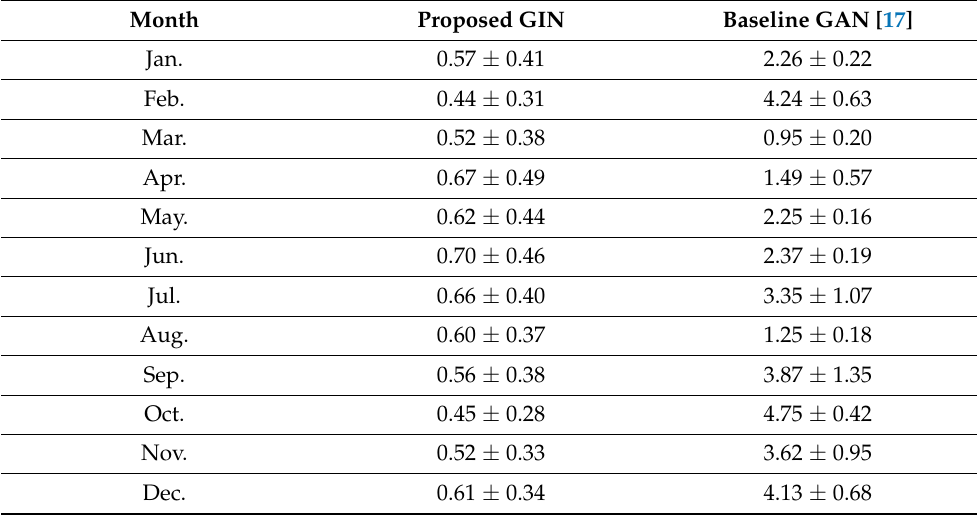
Table 5. MAE ( ◦ C) comparison between the proposed GIN and the state-of-the-art GAN [17] to demonstrate the effectiveness of our novel preprocessing method and joint loss